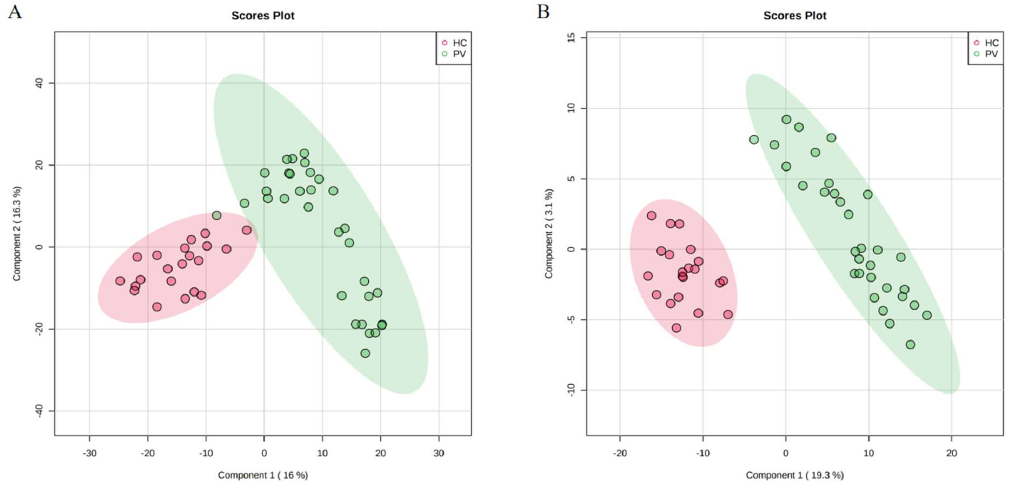
Figure 1. Score plots of serum metabolic profiles of the PV and HC groups. ( A ) PLS-DA score plots for the PV and HC groups in positive mode. ( B ) PLS-DA score plots for the PV and HC groups in negative mode.